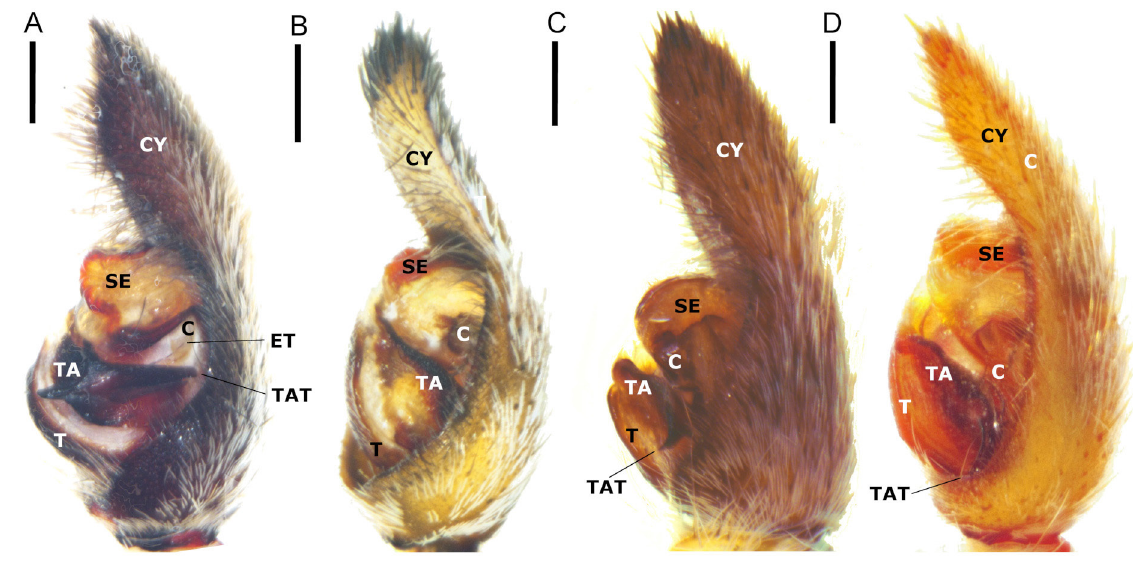
Fig. 3. Male pedipalps, prolateral view. A . Geolycosa vultuosa C.L. Koch, 1838 (HUJ INV-AR20960). B . Lycosa gesserit sp. nov . , holotype (HUJ INV-AR20631). C . Lycosa hyraculus sp. nov . , holotype (HUJ INV-AR20818). D . Lycosa piochardi Simon, 1876 (HUJ INV-AR20948). Scale bars = 0.5 mm. Photos by I. Armiach